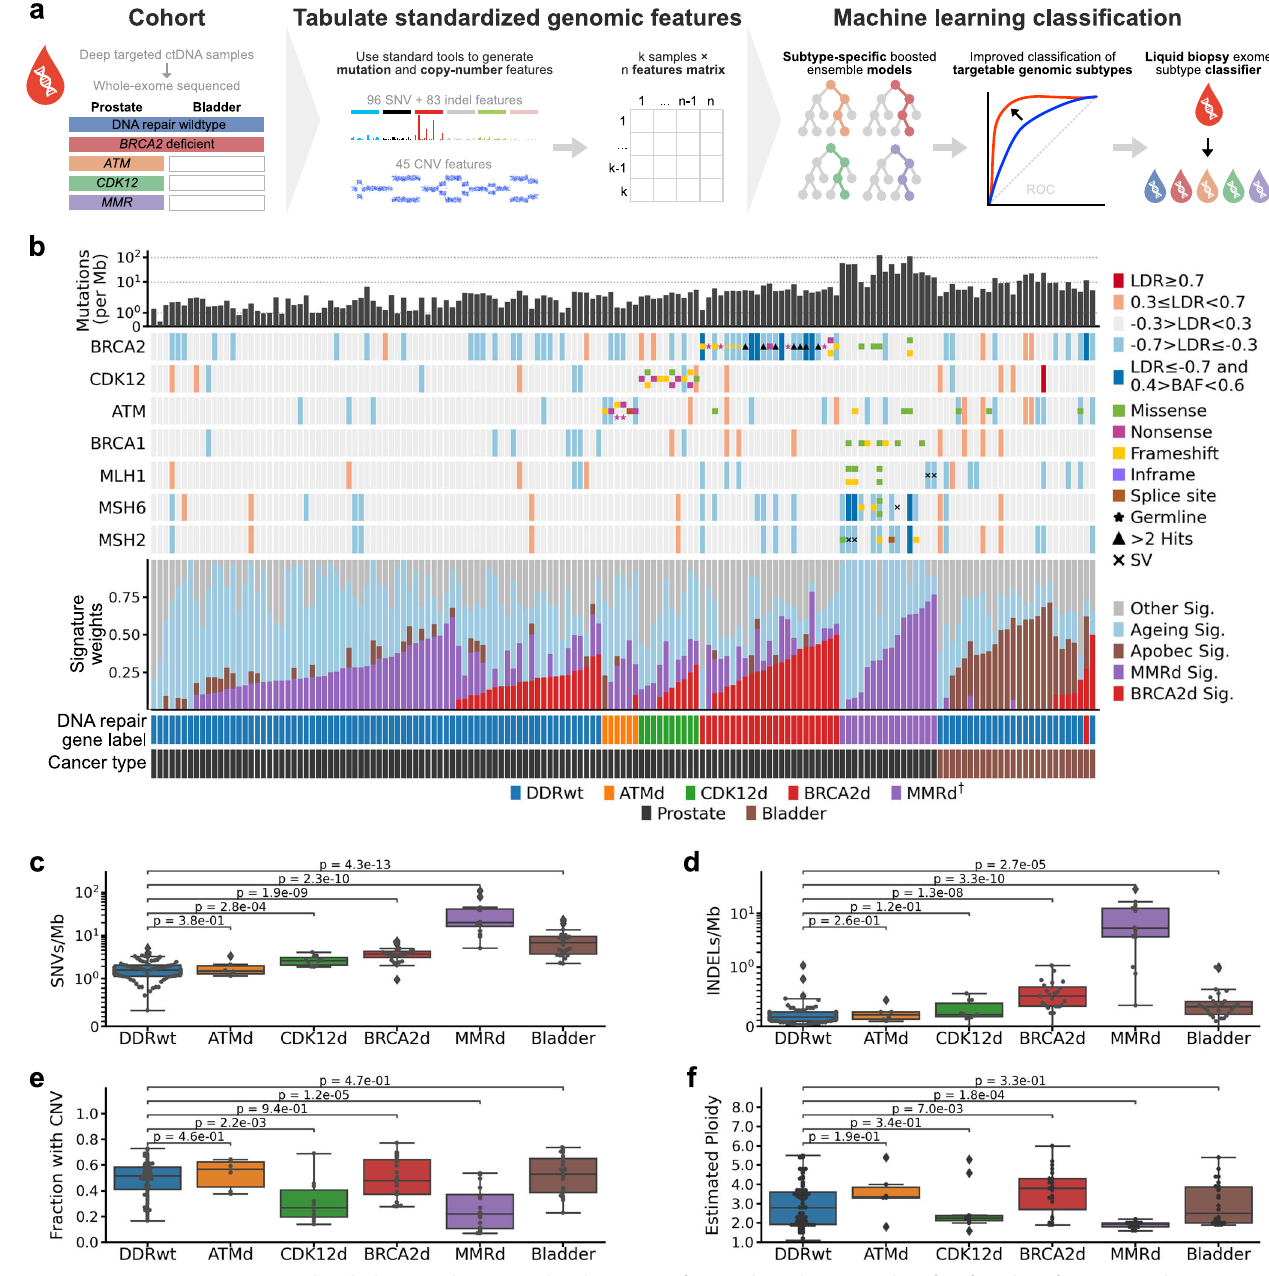
Fig. 1 Dataset overview. a Graphical abstract depicting development of a machine learning classi fi er for identifying DNA damage repair defects in metastatic prostate and bladder cancers. Pre-evaluated clinical ctDNA samples from multiple sources were selected for whole- exome sequencing and used to train interpretable XGBoost models. b Oncoprint showing assigned DNA damage repair labels (assigned from prior deep targeted sequencing) and selected somatic features of the whole-exome sequencing cohort including signature weights and mutation counts. Log depth ratios (LDR) are the normalised average from targeted sequencing. c – f Comparison between naïve somatic features of all samples assigned to each DNA damage repair label, including the number of single nucleotide variants (SNVs) and indels, the proportion of the genome affected by a copy number variant (CNV) relative to base ploidy, and the overall genome ploidy. P -values are from Mann – Whitney U tests. For the box and whisker plots, the box encompasses the interquartile range, the midpoint of the box represents the median, and the whiskers extend 1.5× beyond the interquartile range. † Note that the mismatch repair defective (MMRd) label re fl ects integrated results from ctDNA gene panel sequencing, whole-exome sequencing, intron sequencing as well as immunohistochemical staining of MSH2, MSH6, MLH1, and PMS2 in archival primary